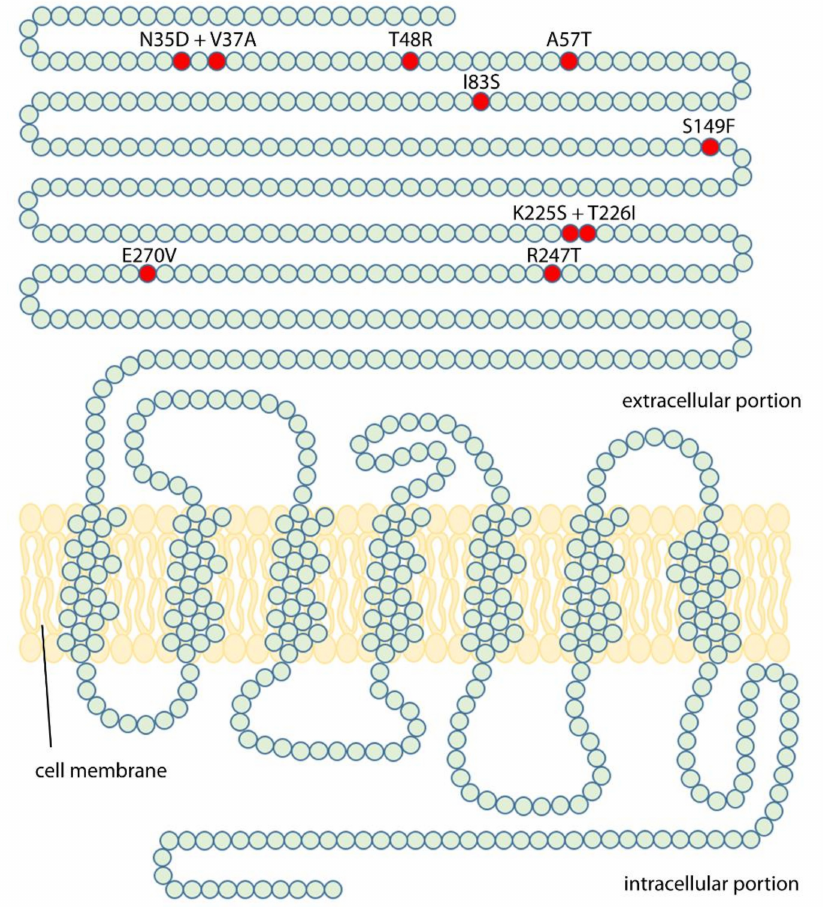
Figure 1. “Murinizing” point mutations induced in the LHCGR protein chain. Amino acid changes were obtained by mutagenesis (see methods) and a total of eight mutant human receptors, carrying mouse luteinizing hormone receptor (mLhr) amino acids in one or two key residues, were